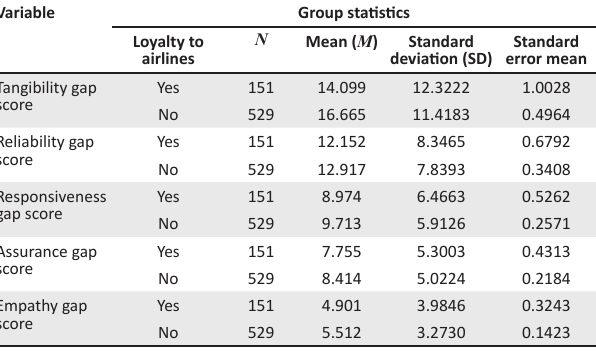
Loyalty programme